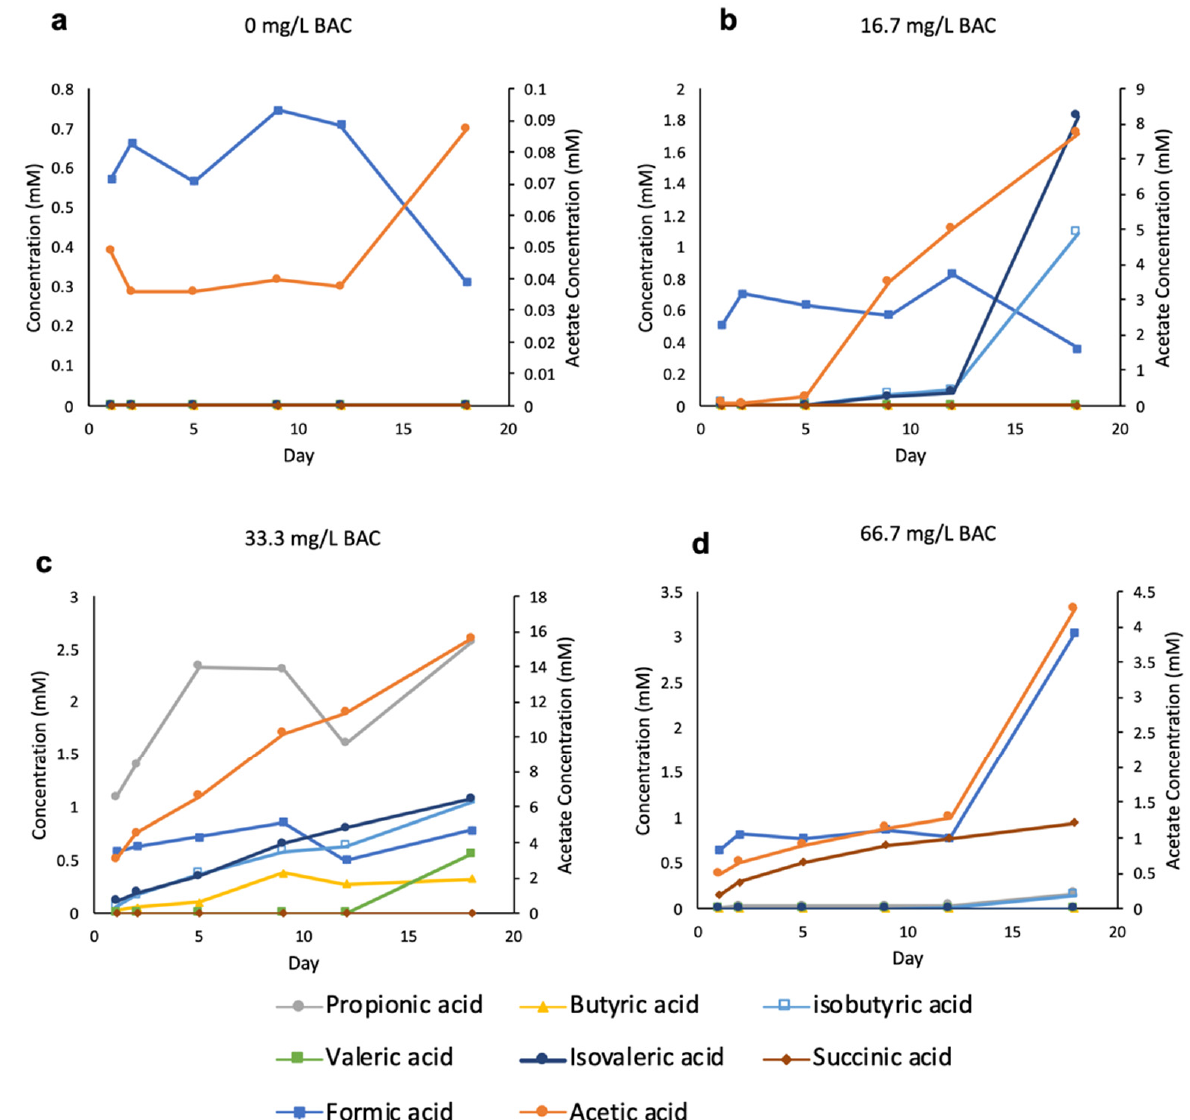
Figure 6. Changes in fatty acid concentrations over time after exposure to BAC as measured using 1 H NMR spectroscopy for ( a ) 0 mg/L BAC, ( b ) 16.7 mg/L BAC, ( c ) 33.3 mg/L BAC, and ( d ) 66.7 mg/L BAC.